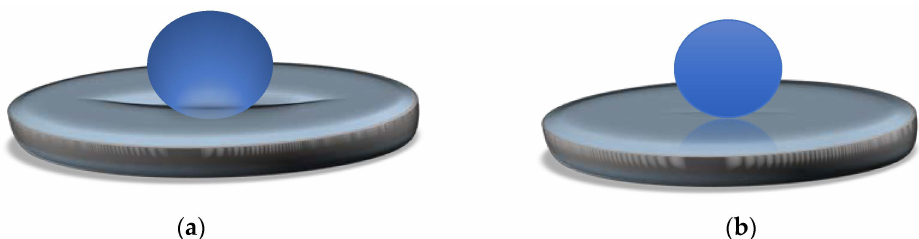
Figure 11. ( a ) Distilled water marble floating on water surface; ( b ) Water marble floating on NaCl aqueous solution.